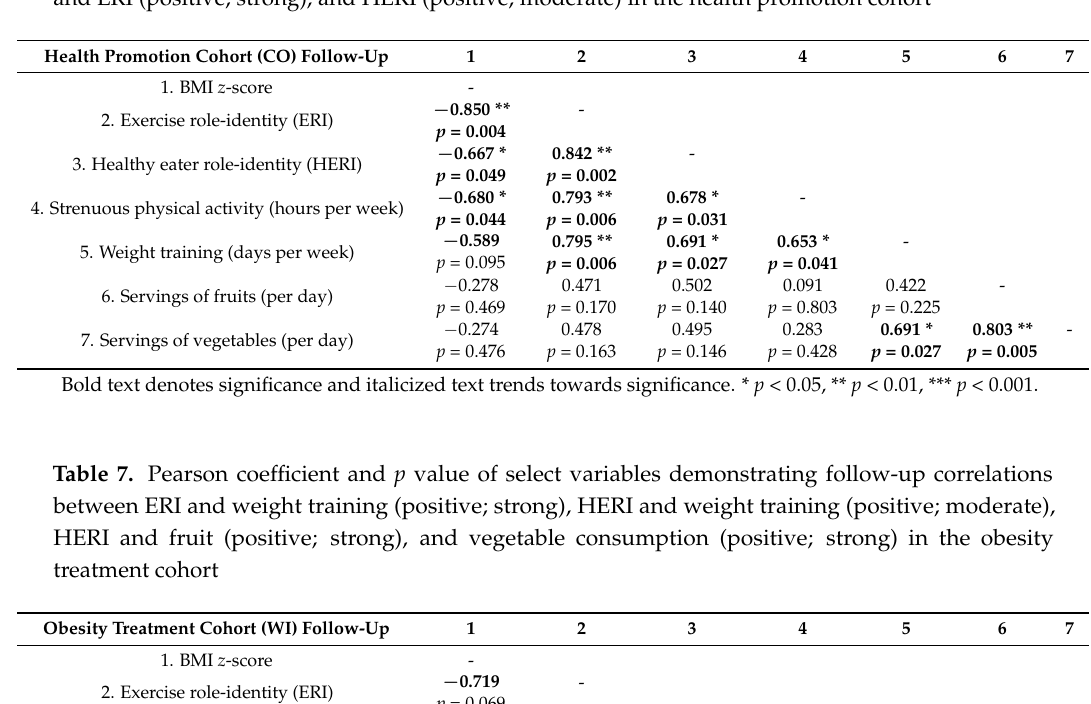
Table 6. Pearson coefficient and p value of select variables demonstrating follow-up correlations between BMI and ERI (negative; strong), BMI and HERI (negative; moderate), ERI and HERI (positive; strong), BMI and strenuous physical activity (negative; moderate), strenuous physical activity and ERI (positive; strong), and HERI (positive; moderate) in the health promotion cohort